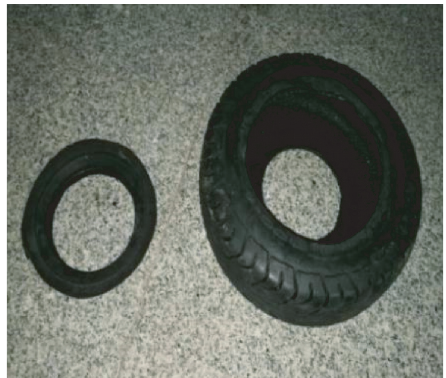
Figure 4: The improved tire.